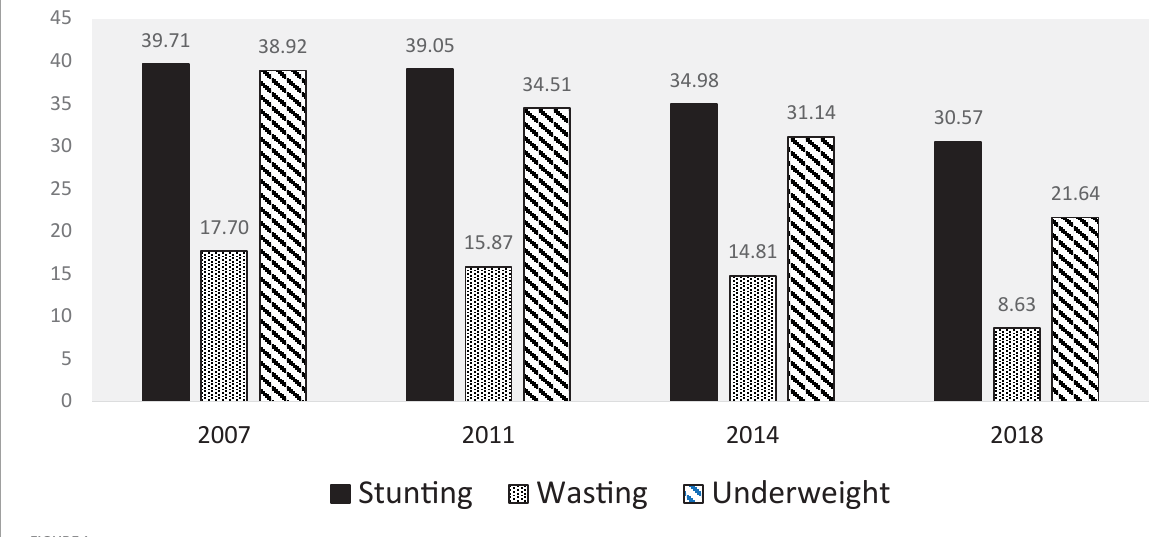
FIGURE1 Proportion of childhood stunting, wasting, and underweight over the period.